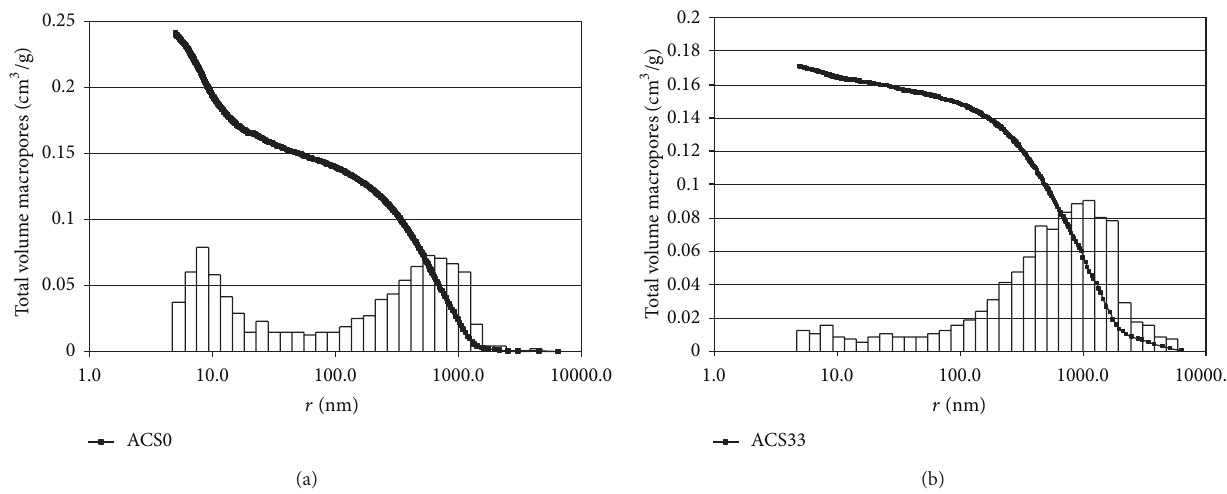
Figure 3: (a) Total volume macropores versus radii for ACS0 active coke. (b) Total volume macropores versus radii for ACS30 active coke.